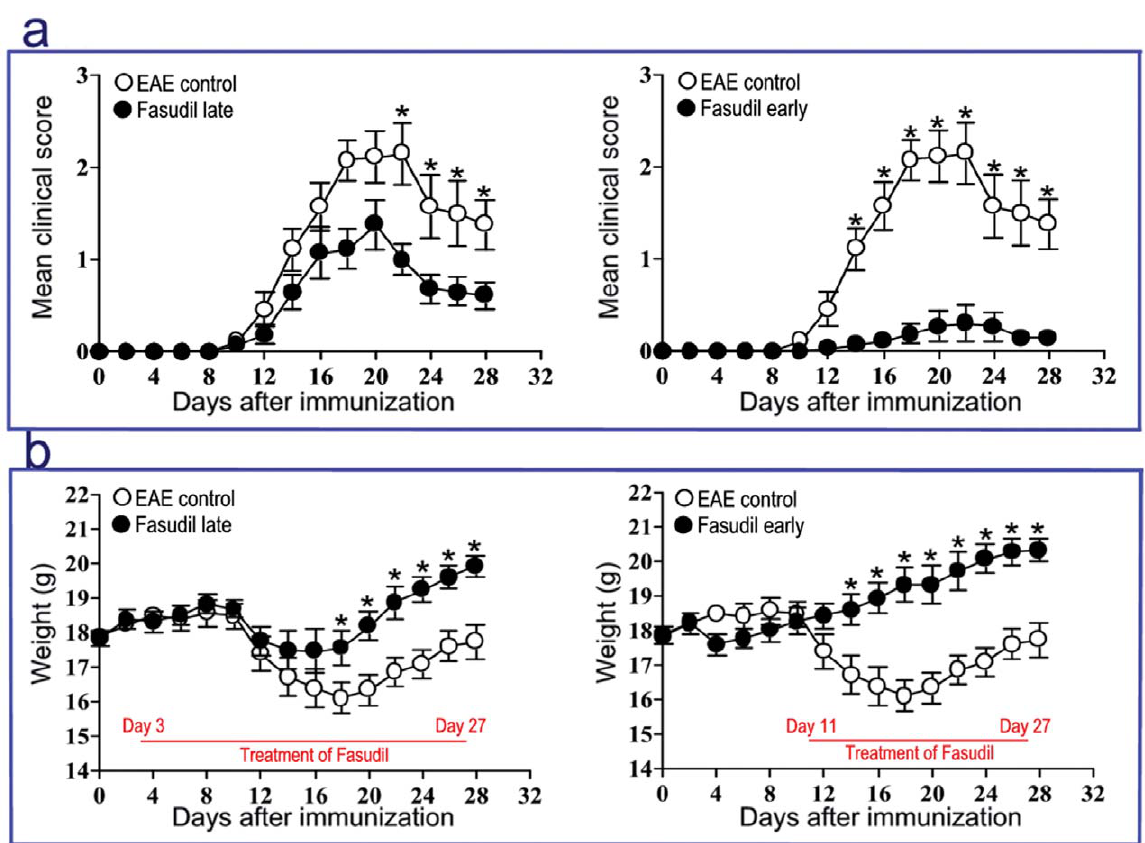
Figure 1. Fasudil delays onset, and ameliorates severity of EAE. Chronic EAE was induced in C57BL/6 mice with MOG 35–55. Fasudil was injected (i.p.) at 40 mg/kg/d every other day on day 3 p.i. (Fasudil early treatment, n=13) or on day 11 p.i. (Fasudil late treatment, n=13). The horizontal line is treatment period of Fasudil. The injection of normal saline was set up as control (EAE control, n=13) in a similar manner. a) Mean clinical score, b) Mean body weight. The comparison in each time point was separately analyzed by Mann Whitney U test after nonparametric Kruskal- Wallis test. * p , 0.05; ** p , 0.01.